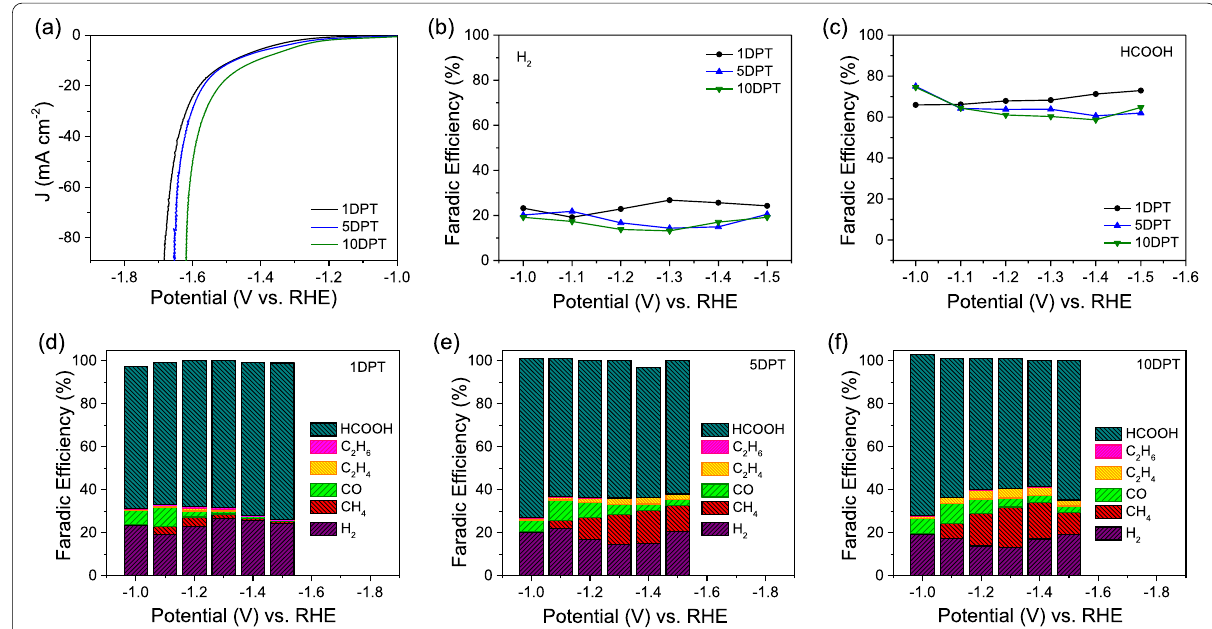
Fig. 3 a Current densities of 1DPT, 5DPT and 10DPT NCs, which characterize the activities of NCs; ( b ) H 2 FE; ( c ) HCOOH FE of 1DPT, 5DPT and 10DPT NCs at different applied potentials (-1 to 1.5 V), which characterize the selectivities of NCs for HCOOH. Proportions of reduction products of ( d )